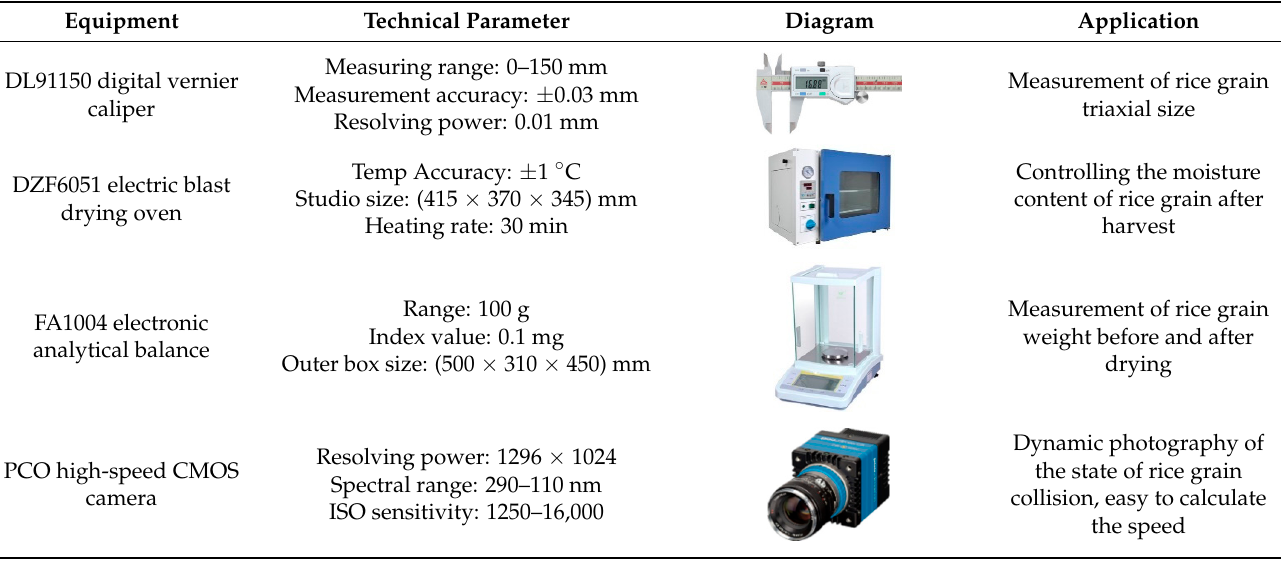
Table 2. The main parameters of instruments.